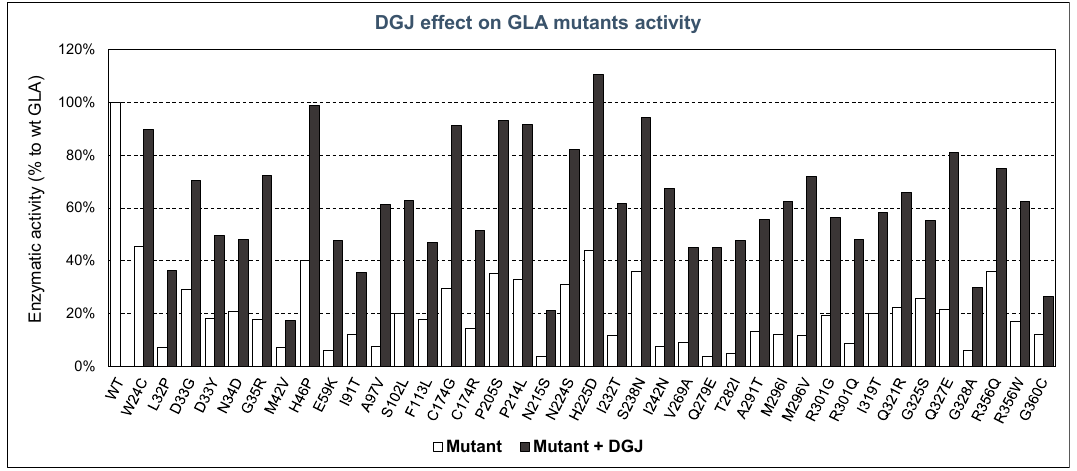
Figure 2. Enzymatic activity of GLA mutants compared with that of wild-type enzyme, and effect of DGJ addition. In white, residual enzymatic activity without DGJ; in black, enzymatic activity after adding DGJ. The mutants shown are examples described by several authors.